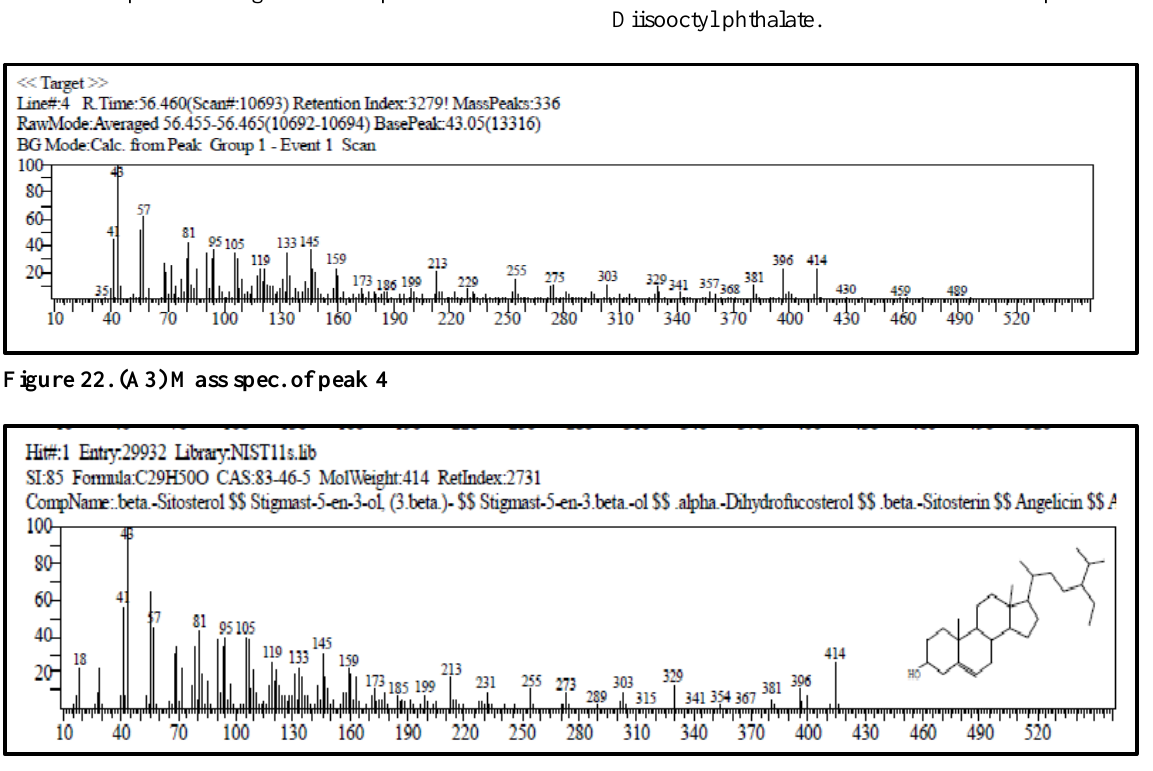
Figure 22. (B3) Mass spec. of beta-Sitosterol Peak 5 is beta-sitosterol due to the exact mass pattern between A3 and B3mass